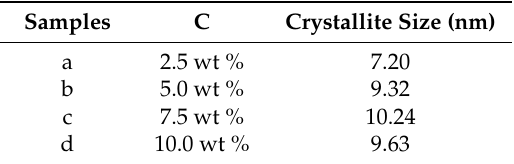
Table 2. The average crystallite size of ACX-MNP-gels from the XRD data.